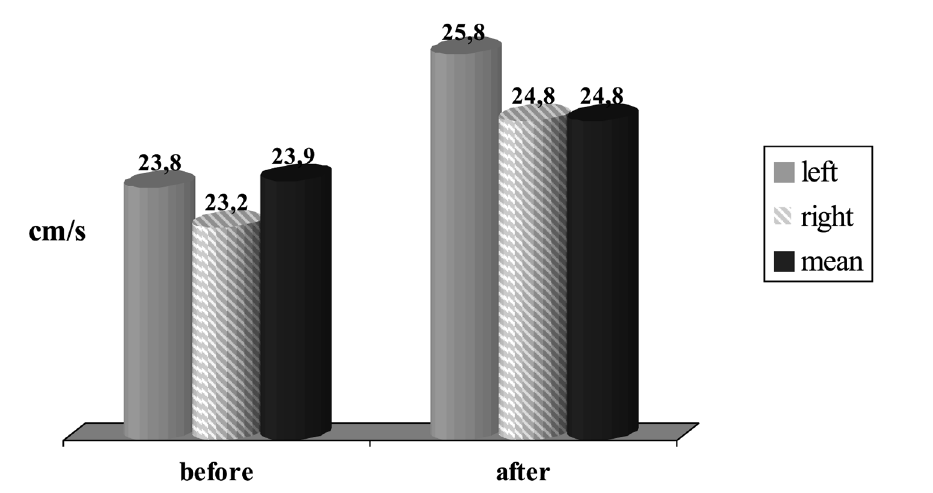
Figure 1 – Mean values of peak systolic velocity of the cavernous arteries before and after administration of sildenafil